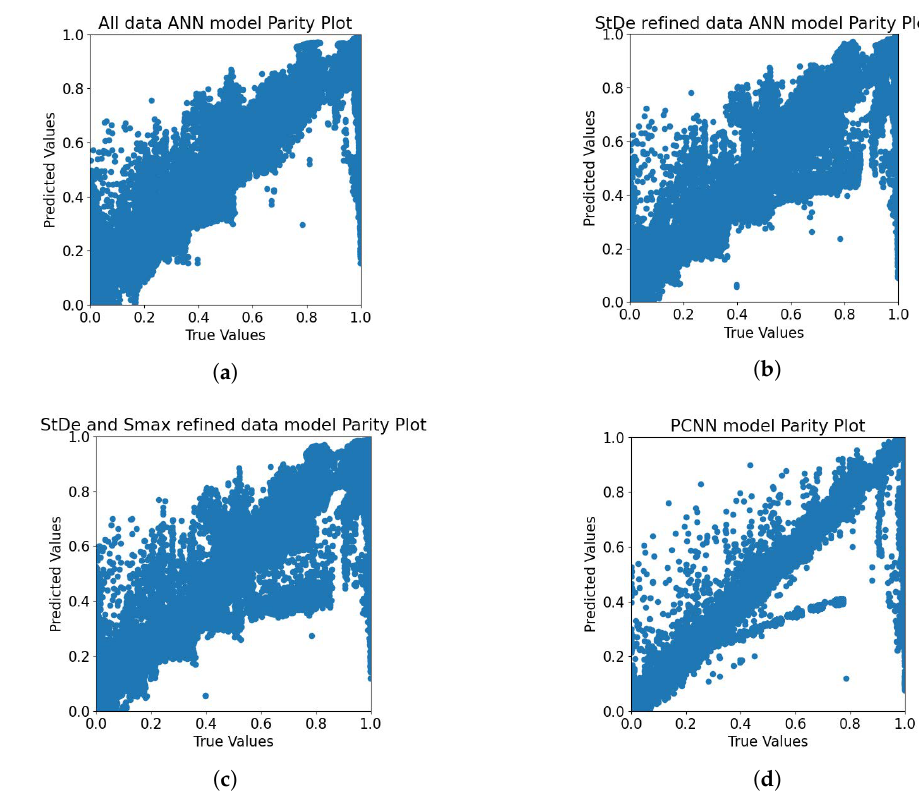
Figure 4. Parity plot for the three ANN models and the PCNN model. The granule density and GSD predictions by each of these models is compared with the test dataset of 10,800 simulated experimental points. The data refined models in subfigure ( b , c ) seem to perform worse than the all data ANN model in subfigure ( a ) and the PCNN model in subfigure ( d